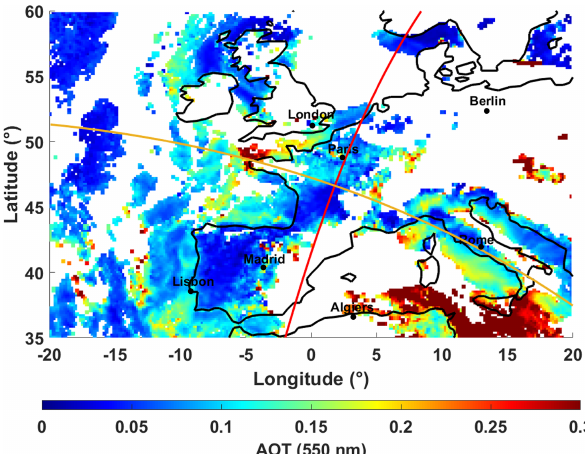
Figure 9. MODIS-derived aerosol optical thickness (AOT) at 550nm on 21 January 2017. Red and orange solid lines, respec- tively show the ground-tracks of CALIPSO–CALIOP (03:19UTC 20 January) and ISS–CATS (02:10UTC 21